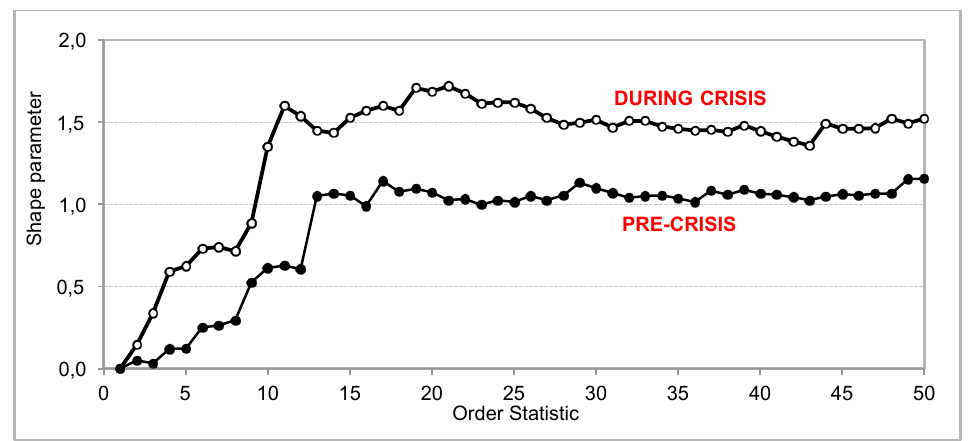
Comparison of estimated shape parameters, using Hill’s method, for the period January 2003 to June 2007 (pre-crisis) and July 2007 to July 2009 (during the crisis) against the order statistic